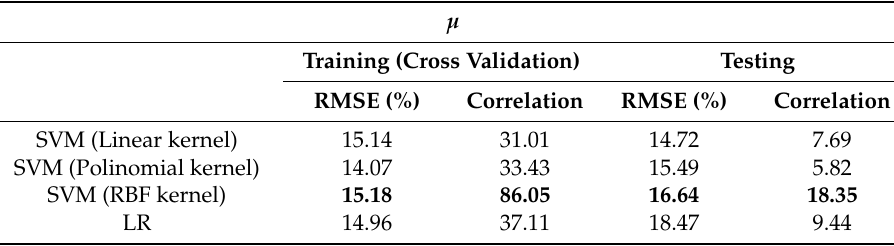
Table 11. Results obtained during the training and testing stages for µ .